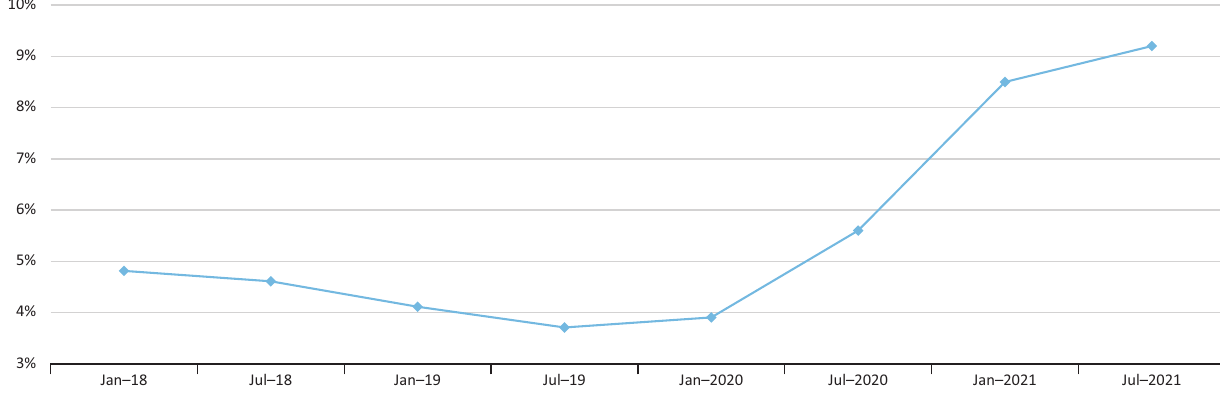
Figure 6. Office vacancy in Sydney from January 2018 to July 2021. Source: Property Council of Australia